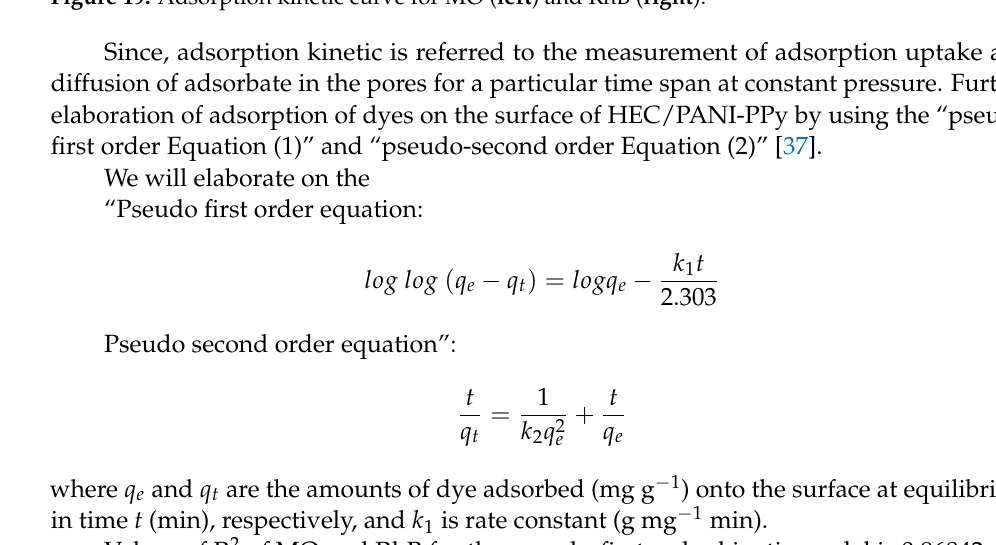
Figure 19. Adsorption kinetic curve for MO ( left ) and RhB ( right ).